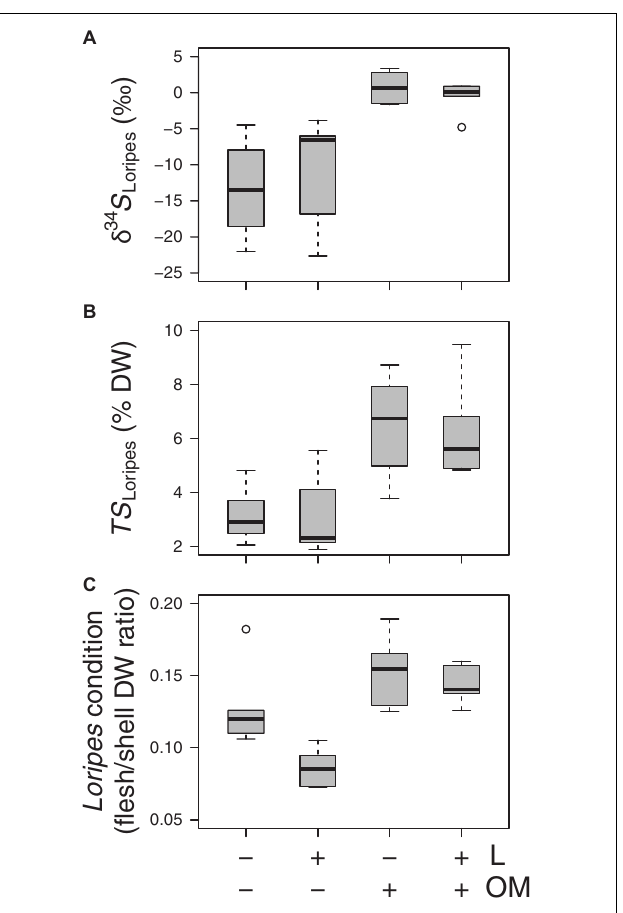
FIGURE 5 | Boxplots of (A) sulfur isotopic signatures of Loripes orbiculatus tissue ( δ 34 S Loripes ), (B) L. orbiculatus flesh total sulfur contents ( TS Loripes ), (C) L. orbiculatus condition expressed as the flesh/shell dry weight (DW) ratio per treatment (n = 6 per treatment) after 50 days. L, addition of L. orbiculatus clams; OM, addition of organic matter. Midline in box; median; box: 25th and 75th percentiles; whiskers: 1.5 × interquartile range; circles: outliers. Note that for each response variable we plotted the mean value per benthic core.